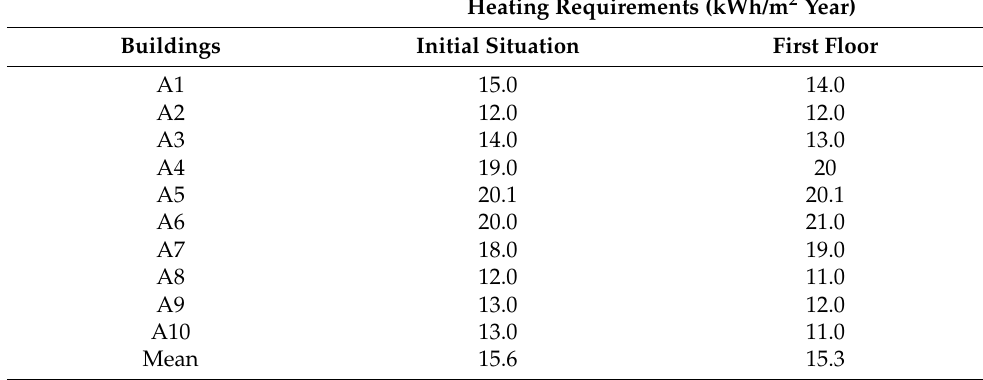
Table 2. Heating requirements of different neighborhood buildings in the basic and high configuration of a